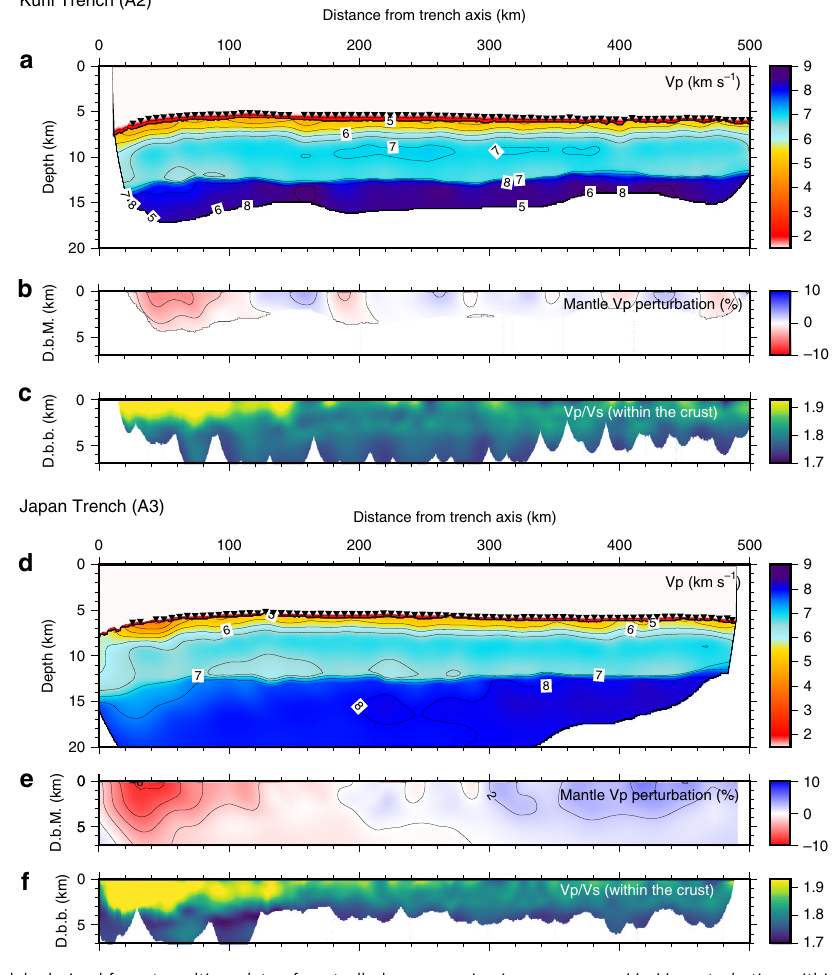
Fig. 3 Seismic velocity models derived from traveltime data of controlled-source seismic surveys. a – c V p , V p perturbation within the mantle, and the V p / V s ratio within the crust along the Kuril Trench pro fi le. d – f V p , V p perturbation within the mantle, and the V p / V s ratio within the crust along and the Japan Trench pro fi le. The inverted triangles in a and d show OBS locations. D.b.M. is depth below the Moho, and D.b.b. is depth below the basement. To enable direct comparisons between the trenches, only the OBSs shown by green circles in Fig. 1 were used to develop these velocity models. Results obtained by using all OBSs are shown in Supplementary Fig. 6. The reduction of mantle V p become signi fi cant near the trench along both lines, which is well correlated with the development of normal faults (Supplementary Fig. 3b). The increase of V p / V s ratio within the crust starts at about 150 km from the trench axis and are well correlated with the roughness (continuity) of the basement re fl ection (Supplementary Fig. 3c), suggesting fracturing at the basement